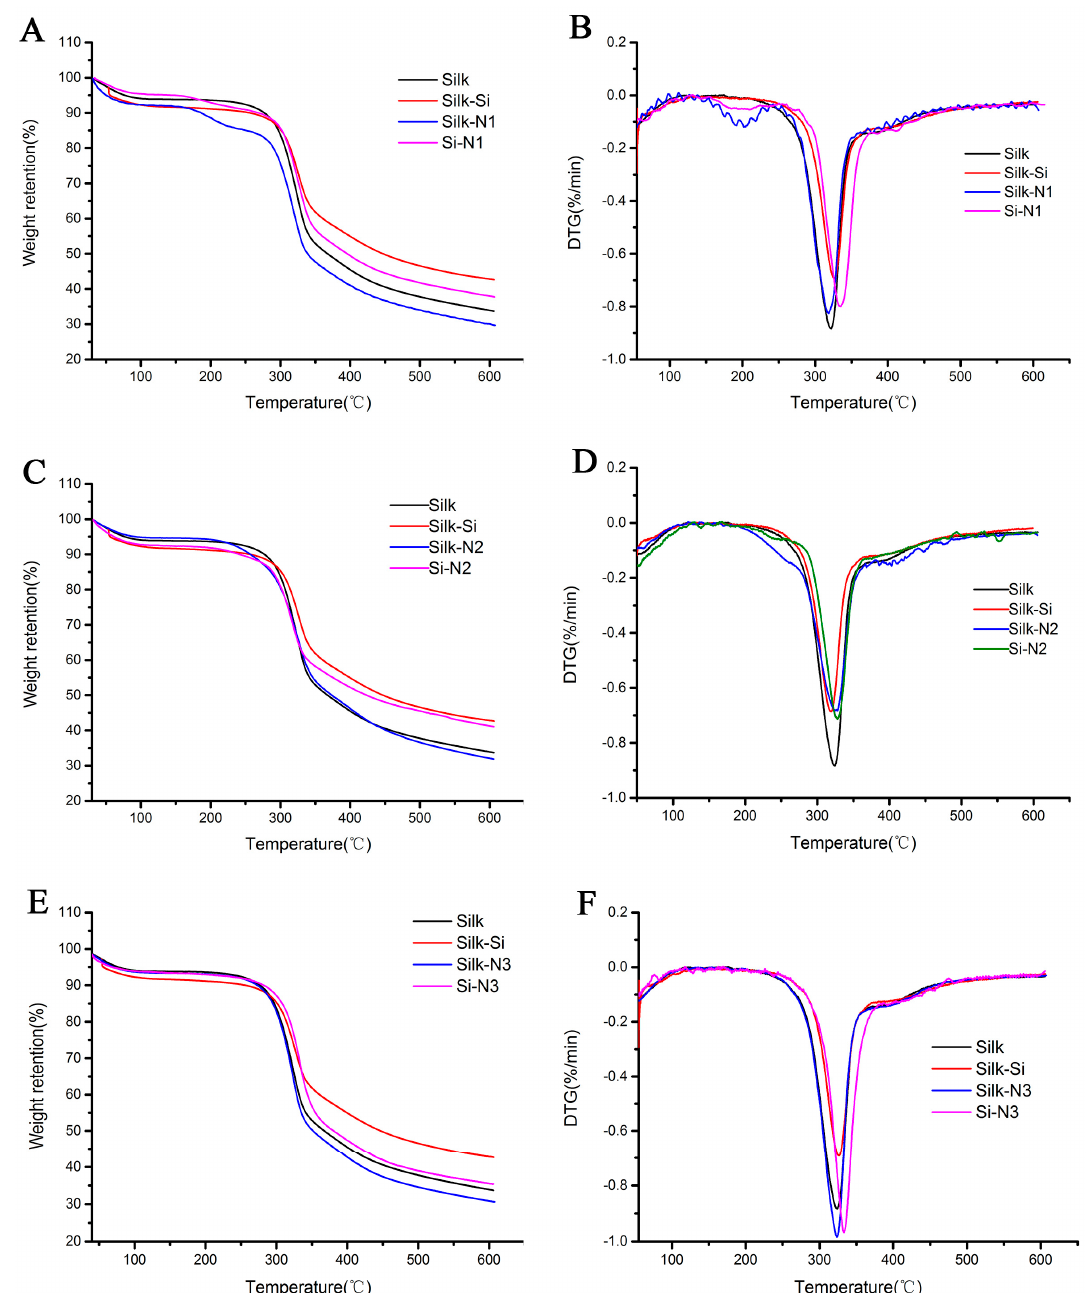
Figure 7. TG ( A , C , E ) and DTG ( B , D , F ) curves of Silk and Silk-N 1 , Silk-N 2 and Silk-N 3 , Si-N 1 and Si-N 2 , Si-N 3 samples in nitrogen atmosphere.